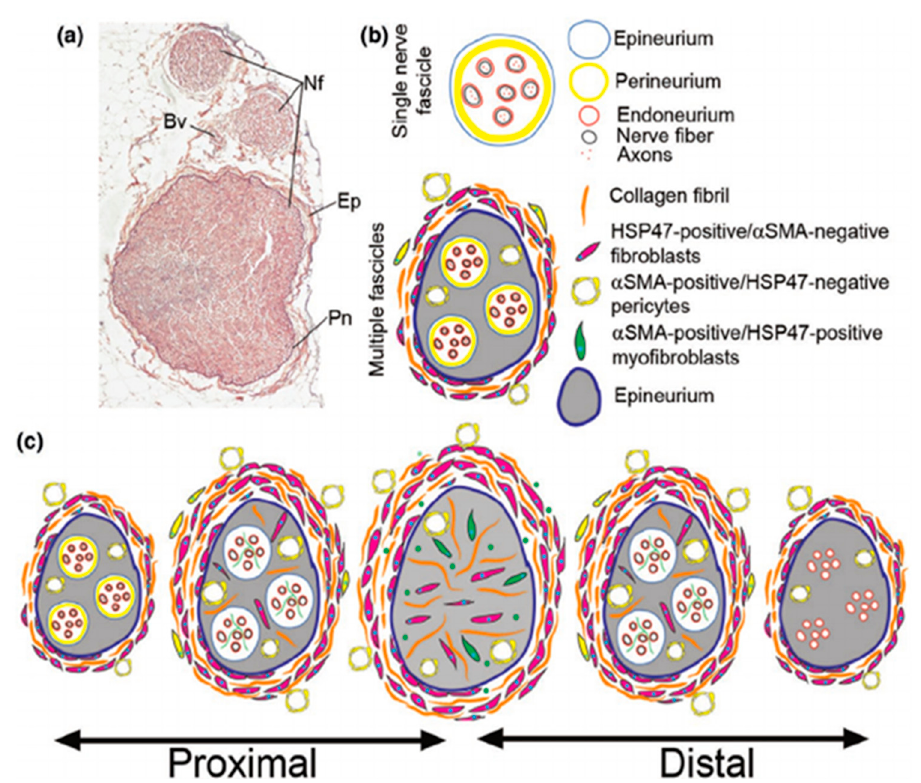
Figure 4. Overview of the scar region of the sciatic nerve for weeks after injury following chronic M1 macrophage activation. The schematic depicts crucial elements of the scar including blood vessels, collagen fibrils and contributing cells in the scar formation process. HSP47—Heat shock protein 47, α SMA—alpha Smooth Muscle Actin (Adapted from [39] , John Wiley & Sons, Inc., 2020).